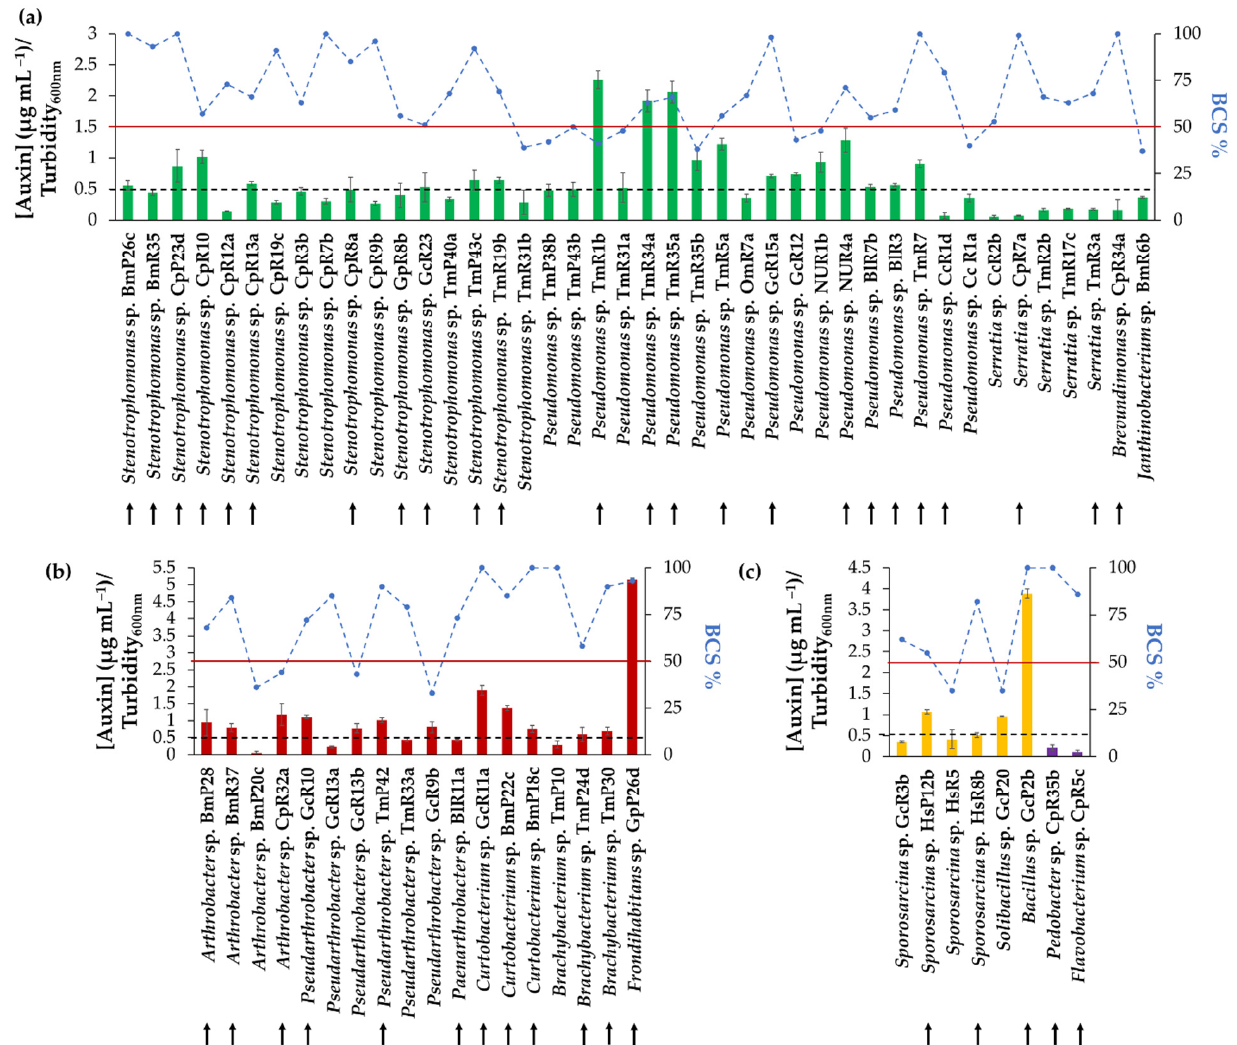
Figure 3. Auxin production and bacterial cell survival percentage (BCS%) of bacterial strains. ( a ) Auxin production and BCS% of Proteobacteria (green bars). ( b ) Auxin production and BCS% of Actinobacteria (red bars). ( c ) Auxin production and BCS% of Firmicutes (yellow bars) and Bacteroidetes (purple bars). The blue dots (joined by dotted lines) represent BCS% of each isolate. The solid red line is the 50% BCS value. The dashed black line represents the value of [Auxin] (µg mL − 1 )/Turbidity 600nm = 0.5 µg mL − 1 . Small black arrows indicate selected strains. Each value is a mean ± SD of three independent trials.